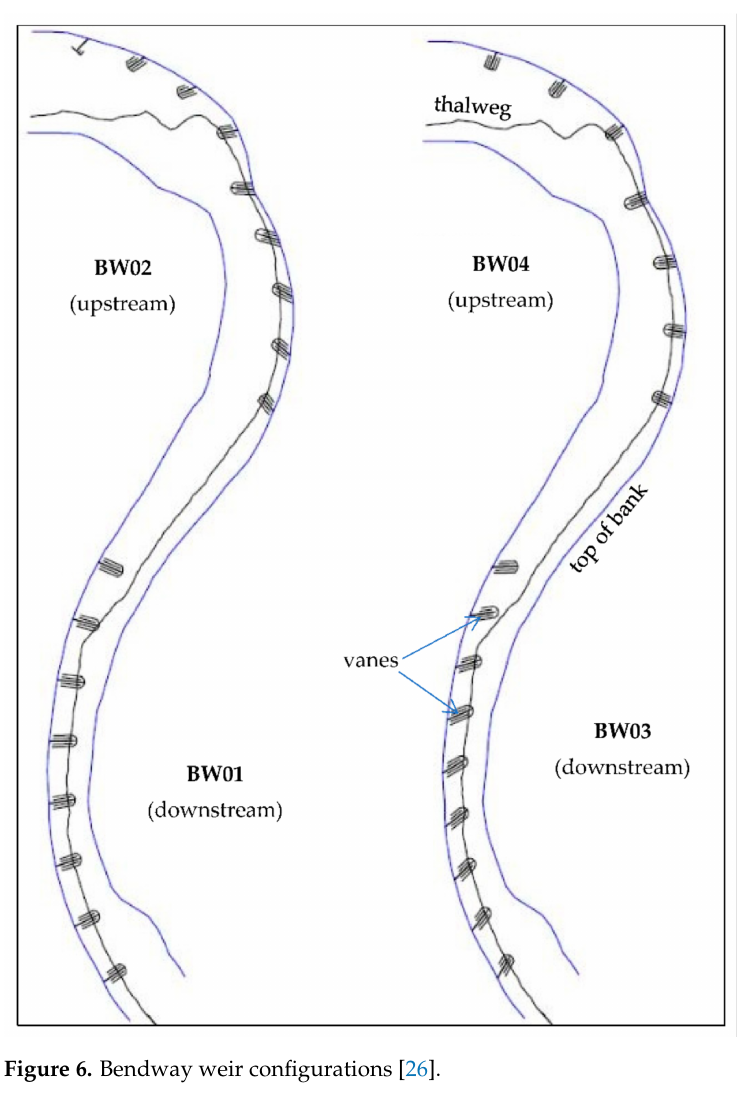
Figure 6. Bendway weir configurations [26].